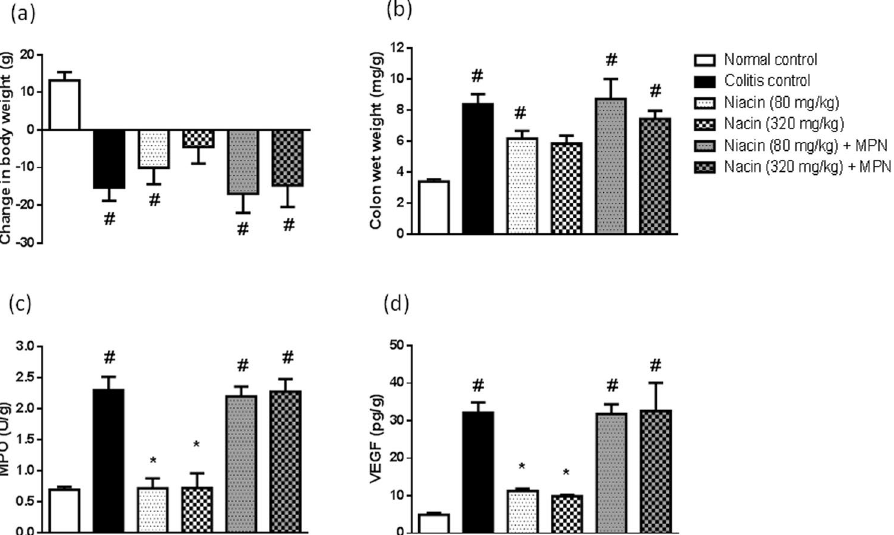
Figure 6. Role of GPR109A in the protective effect of niacin against iodoacetamide-induced colitis in rats. ( a ) increase in body weight of animals measured from the time of induction of colitis until sacrifice, (b ) colon wet weight, ( c ) Myeloperoxidase (MPO) activity, ( d ) vascular endothelial growth factor (VEGF). Data are expressed as means ± SEM of 5 animals. # P ≤ 0.05 vs. normal control, * P ≤ 0.05 vs. colitis